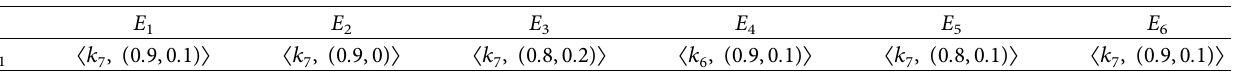
Table 8: Ideal concrete.